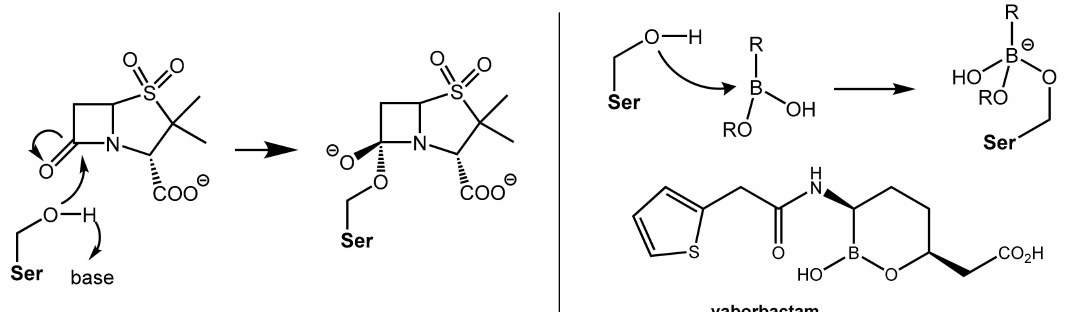
Figure 6. ( Left ): Formation of a tetrahedral, negatively charged intermediate as the first step of the reaction of the β -lactamase inhibitor sulbactam with a serine residue in the active site of a β -lactamase. ( Right ): In an analogous manner, boronic acid derivatives like vaborbactam can reversibly form negatively charged adducts with a serine residue in the active site of β